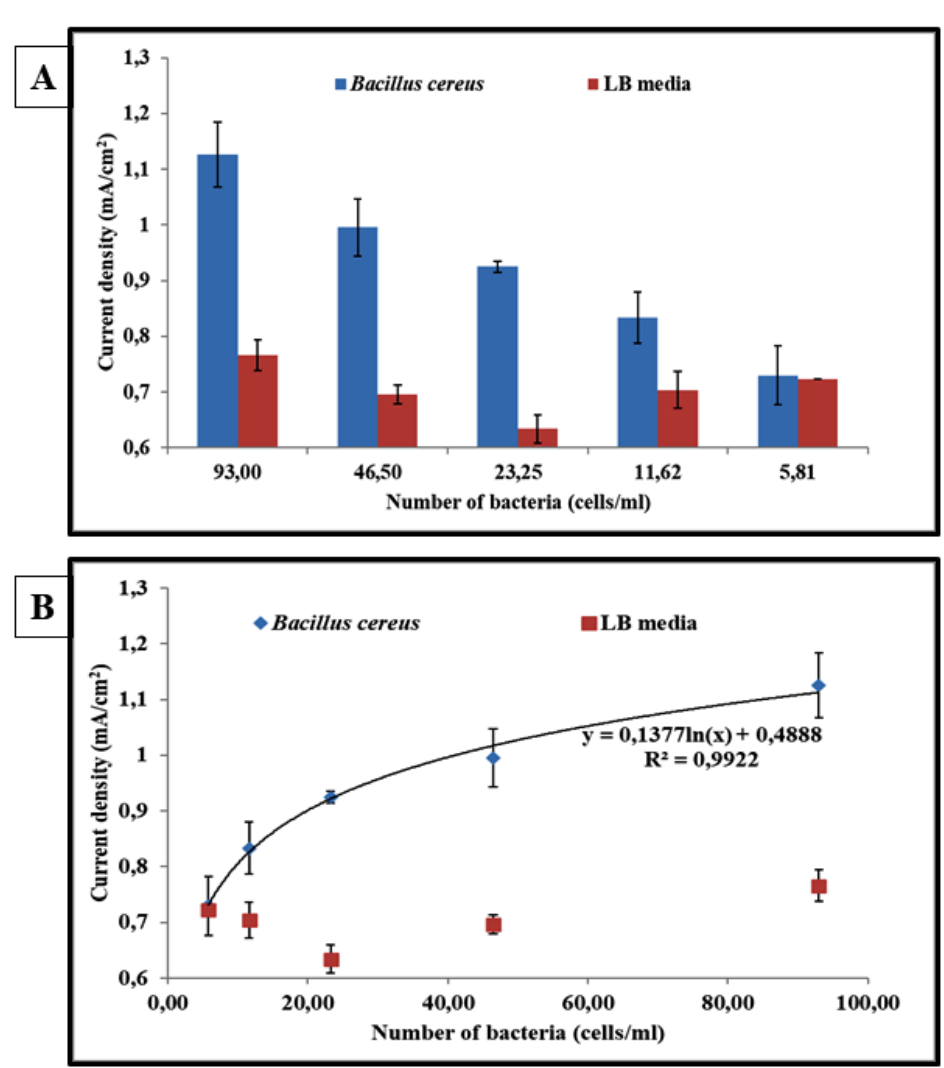
Figure 5. Diagrams correspond to the response of the centri-chronoamperometric assay to various B. cereus concentrations ranging from 6 cells/mL to 93 cells/mL (blue) and to various concentrations of noninoculated LB media in 1 M HCl solution (red) ( A ). Response corresponds to the electrocatalytic signal highlighting the bacterial detection. The curve indicates the fitting of the experimental data with a logarithmic regression: current density = 0.1377 × ln ( B. cereus concentration) + 0.4888 (R 2 = 0.9922) ( B ).